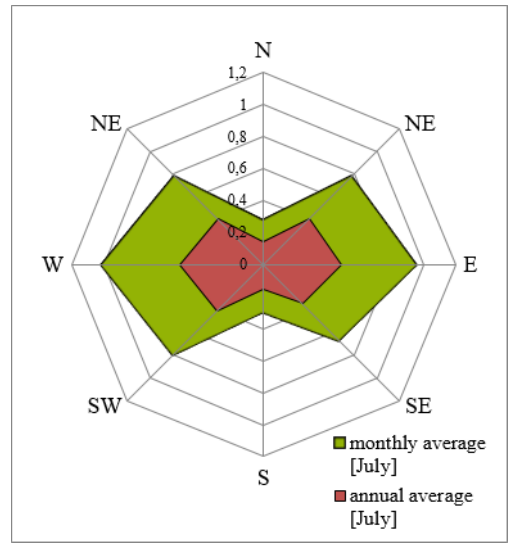
Figure 8. Radar chart of averaged daily-received energy for walls with different orientation [kWh/m 2 ] for December and